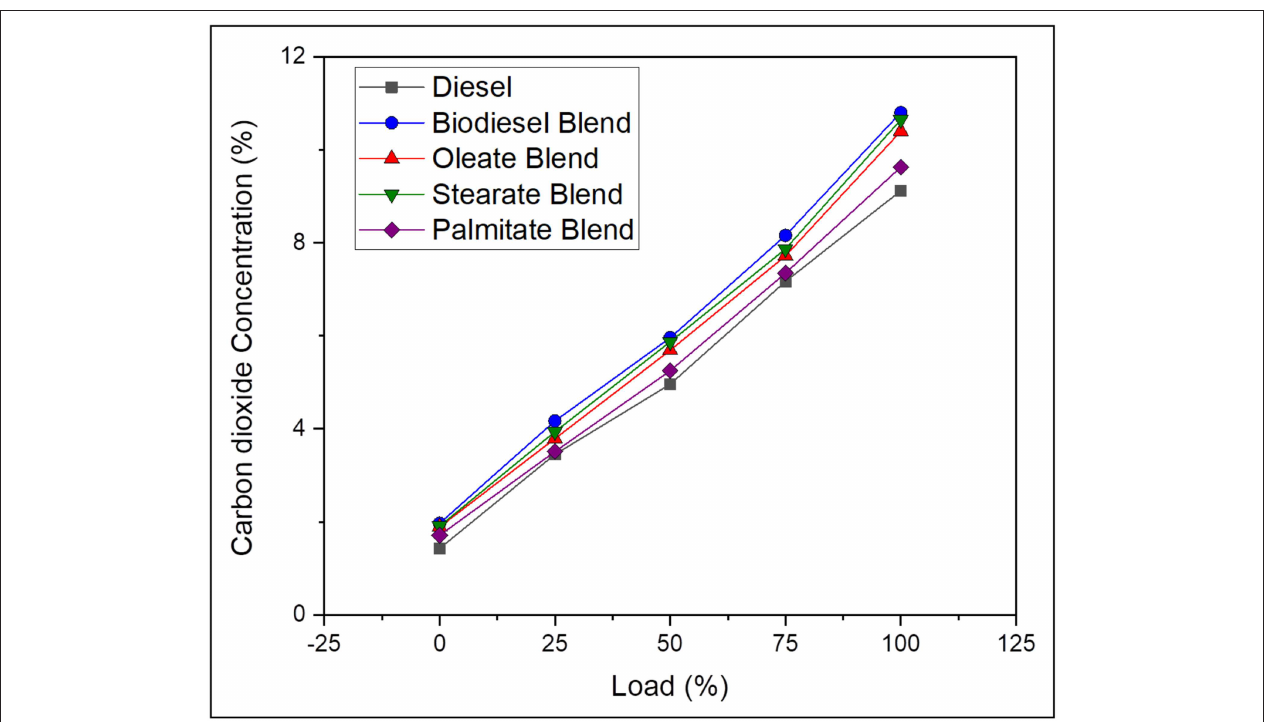
FIGURE 6 | CO 2 emission concentration of diesel and blend samples for varying load conditions.